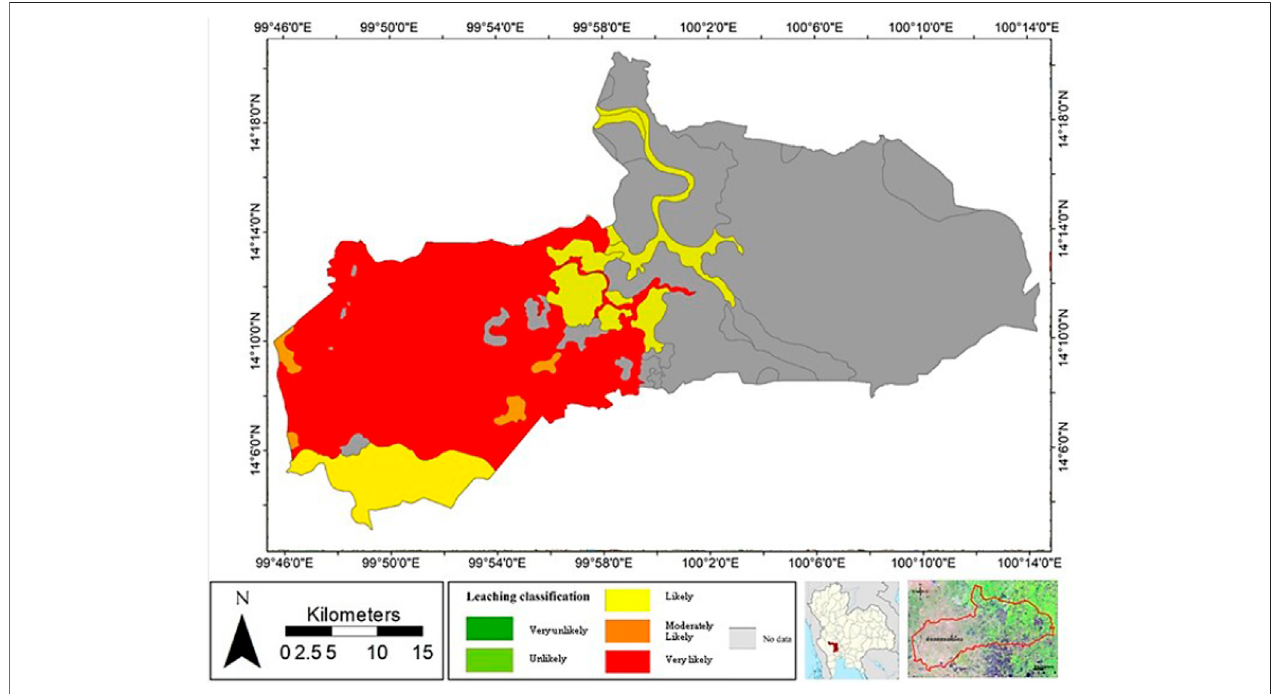
FIGURE 7 | Leaching potential map for atrazine in the study area.